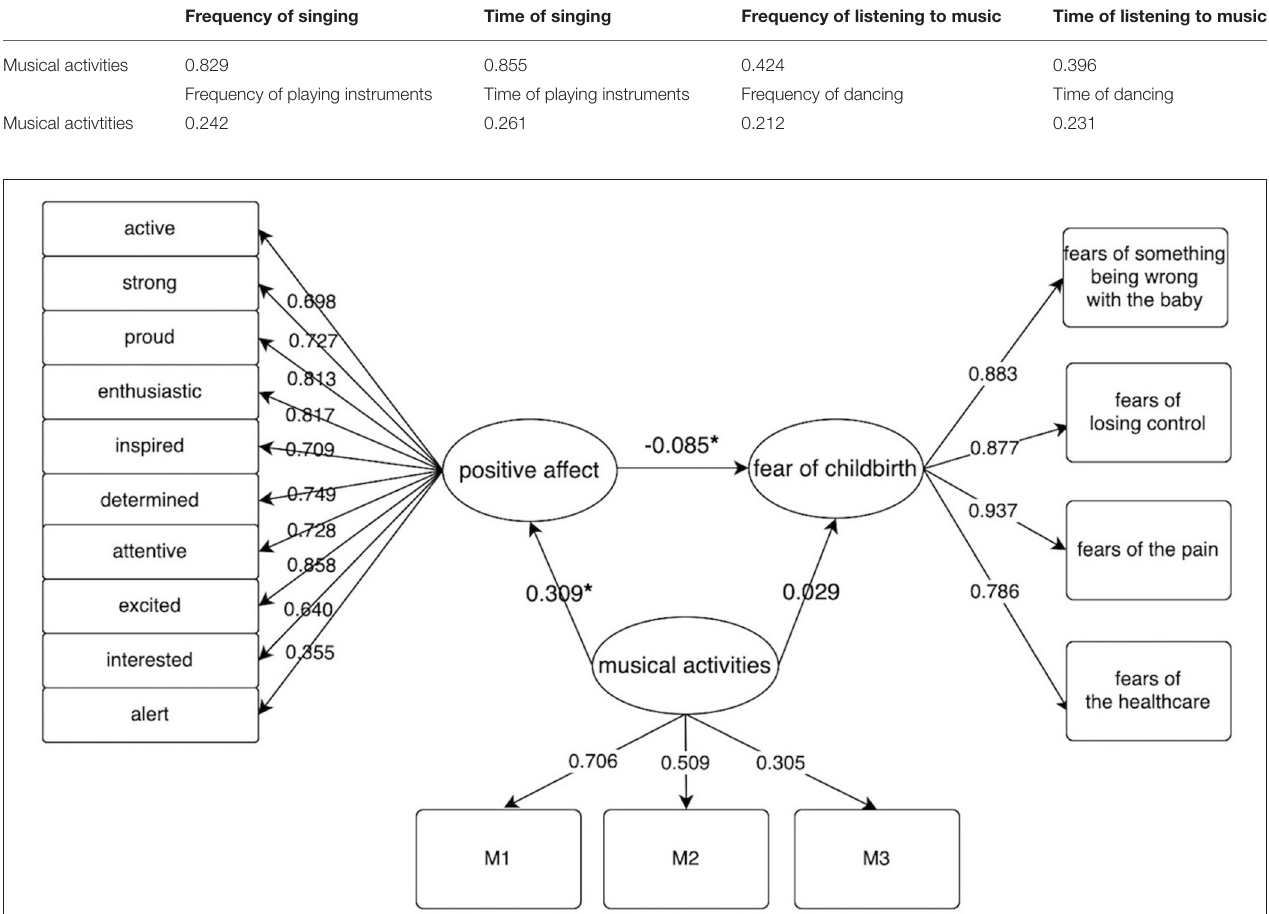
TABLE 2 | The observational variables’ loadings of the musical activities.